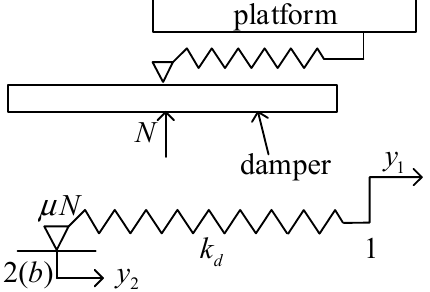
Figure 4. Friction contact model between the damper and the platform.